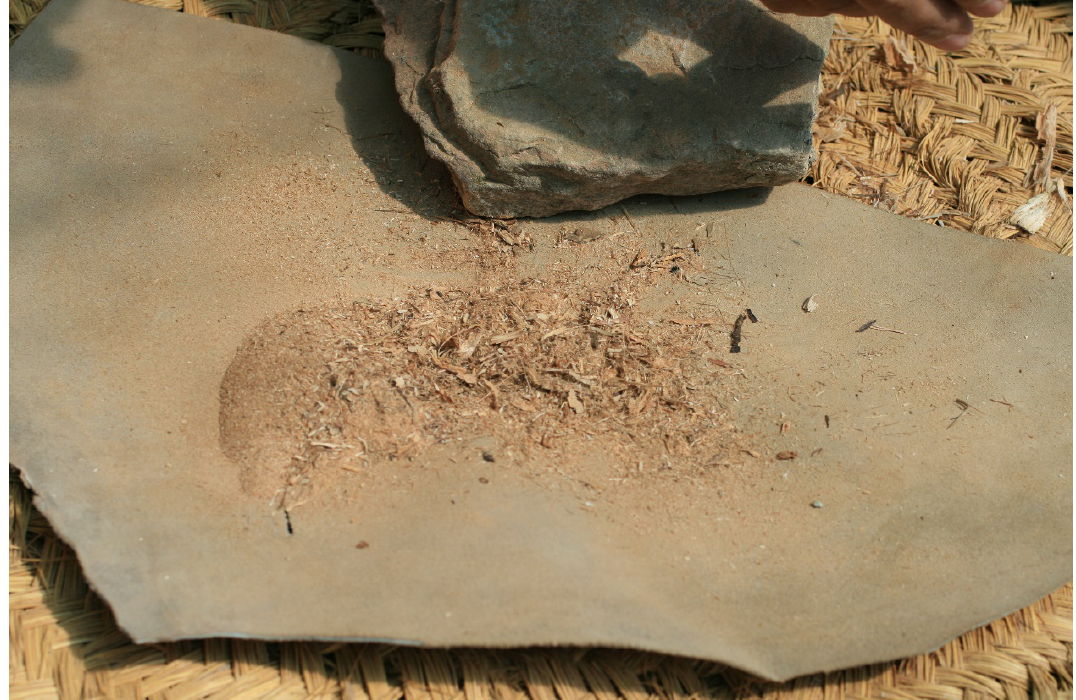
Figure 9. "Flour" from dried cattail rhizomes obtained during the